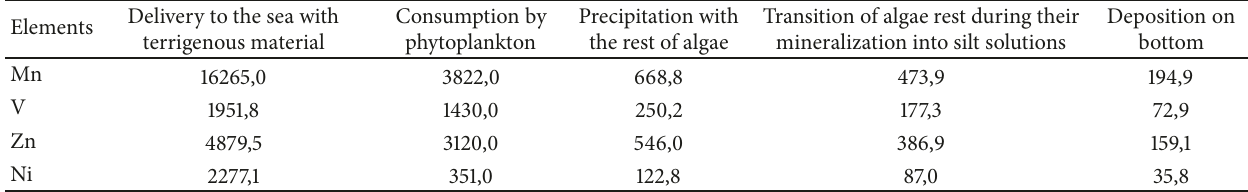
Table 3: Consumption of microelements by phytoplankton and their deposition with remnants of planktonic algae in the bottom deposits of the Azov Sea, t. Delivery to the sea with Elements